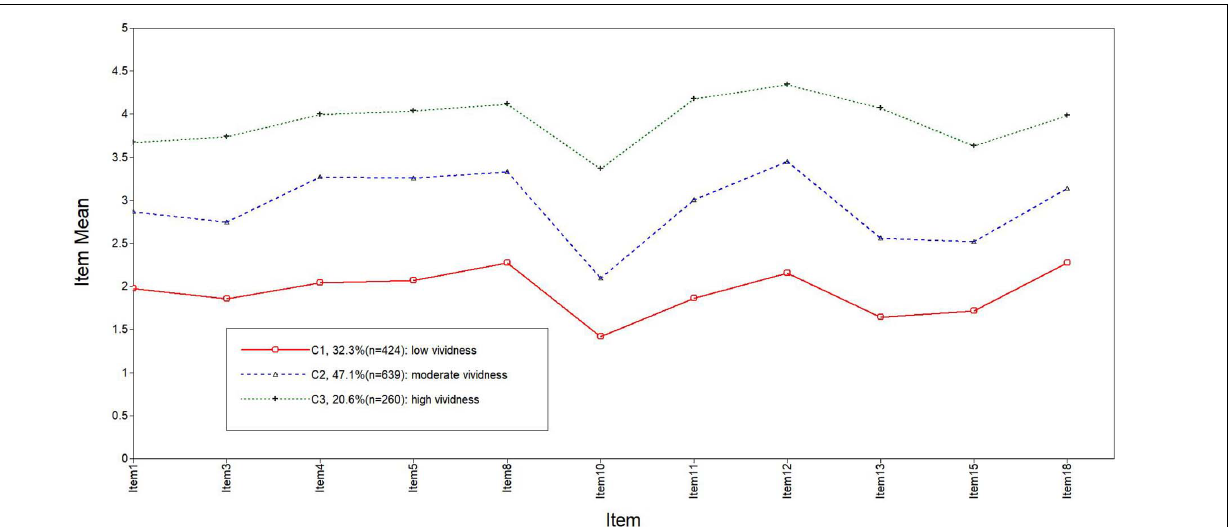
FIGURE 1 | Plot of the standardized mean scores on the positive subscale across the three latent